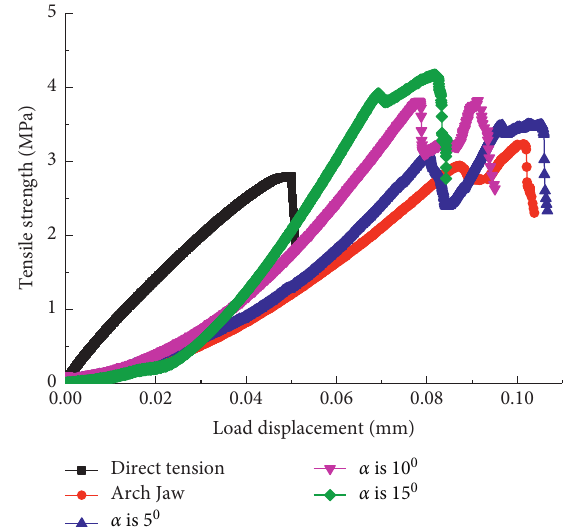
Figure 5: Typical loading curves for the loading rate of 0.05 mm/